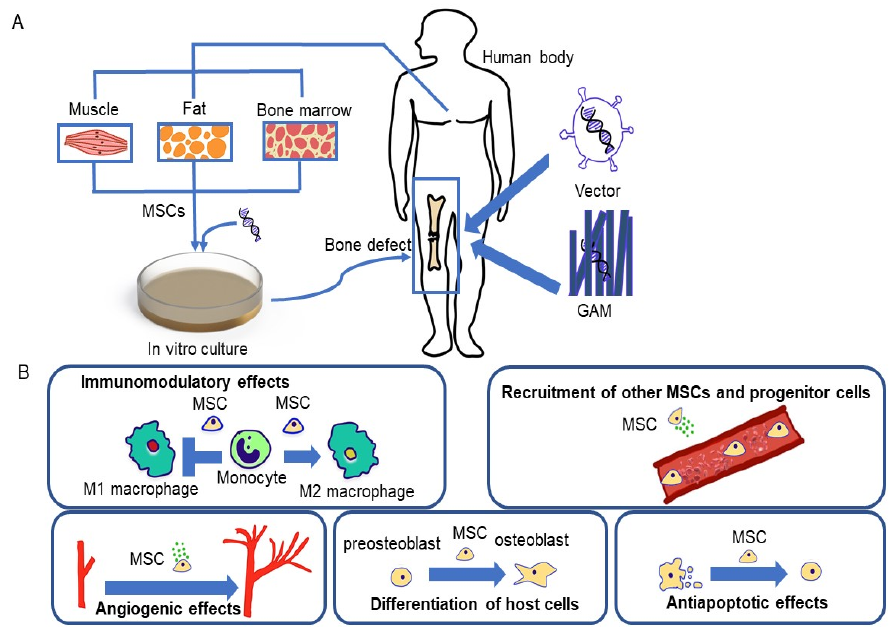
Figure 2. The functions, source, and genetic therapy of mesenchymal stem cells (MSCs); ( A ) Methods of gene engineering MSCs. ( B ) Functions of MSCs in bone regeneration and repair. The favorable effects include immunomodulatory effects, stimulation of angiogenesis, antiapoptotic effects on osteoblasts, recruitment of host MSCs/progenitor cells, and stimulation of their differentiation into osteoblasts.